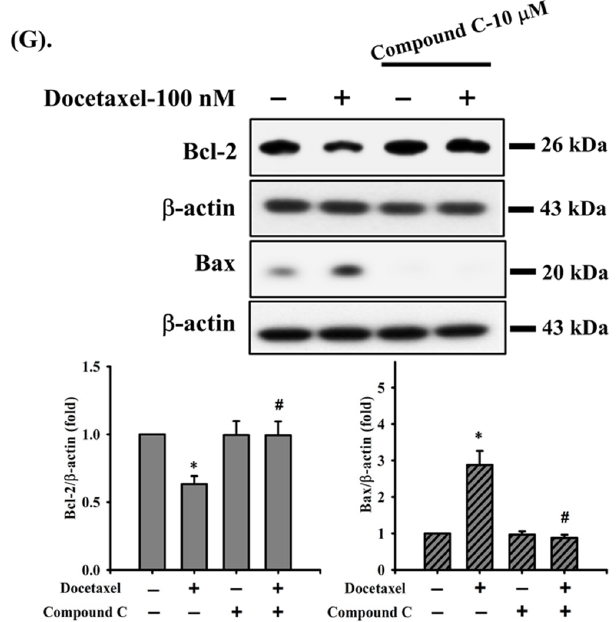
Figure 2. Effects of docetaxel on mitochondrial transmembrane potential (MMP), cytosolic cytochrome c protein expression, and mitochondrial damage-related mRNA expression in human tongue squamous carcinoma-derived SAS cells. ( A ) Cells were treated with docetaxel (100 nM) for 24, 36, and 48 h. MMP was determined by flow cytometer with a fluorescent dye DiOC 6 -FITC. ( B ) Cells were treated with docetaxel (100 nM) for 24 and 48 h. Cytosolic cytochrome c protein expression was determined by Western blot analysis. Cells were treated with docetaxel (100 nM) for 24, 36, and 48 h. The mRNA expression of ( C ) Bax , Bak , Bad , and p53 and ( D ) Bcl-2 was determined by RT-qRT-PCR analysis. Additionally, SAS cells were pretreated with SP600125 (a JNK inhibitor; 20 μ M), PD98059 (an MEK1/2 inhibitor; 20 μ M), and compound c (an AMPK inhibitor; 10 μ M) for 1 h and then treated with or without docetaxel for 48 h, and ( E , F , G ) the protein expression of Bcl-2 and Bax was determined by Western blot analysis. Data in ( A , C , D ) are presented as the means ± SD of four independent experiments with triplicate determination. Results are shown in ( B , E – G ) with representative images, and quantification was performed by densitometric analysis. Each presented bar is the mean ± SD of three independent experiments. Statistical analysis was performed with one-way ANOVA analysis followed by Tukey’s post hoc test. * p < 0.05 compared with vehicle control. # p < 0.05 compared with docetaxel treatment group.